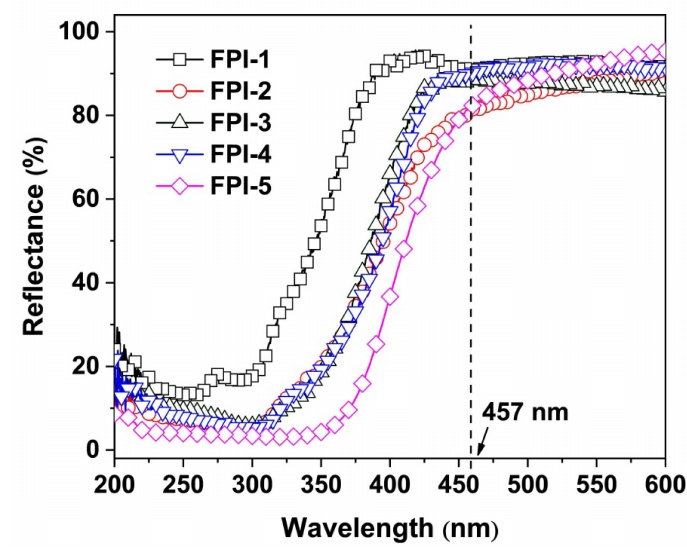
Figure 6. UV-Vis reflective spectra of FPI UFMs.